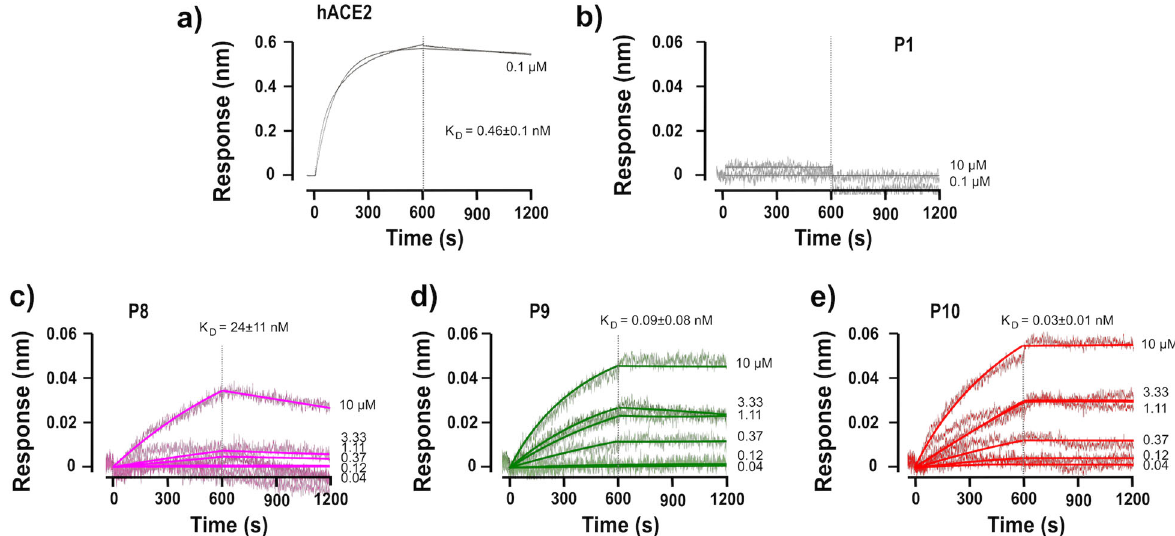
Fig. 4 Helical peptide-mimics of hACE2 strongly bind to the spike RBD. The Fc-tagged 2019-nCoV RBD-SD1 (Sanyou Biopharmaceuticals Co. Ltd)